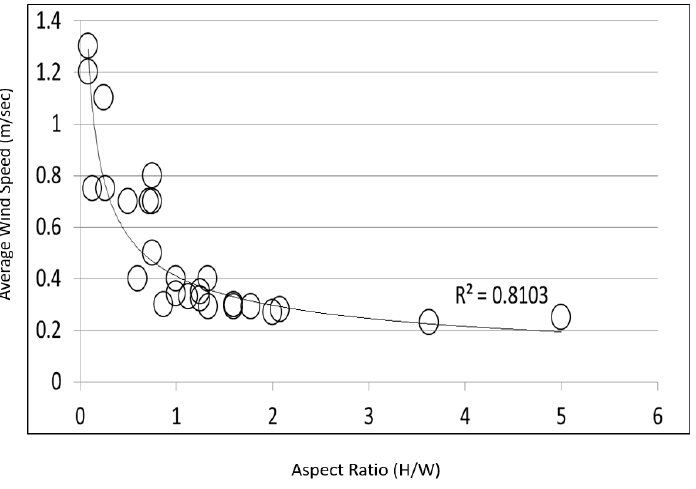
Figure 17. Entry and Exit Wind Speed in Canyons with Air Flow Parallel to their Axis. 7. Conclusions Urban overheating causes energy, environmental, and health problems while also impacting the overall economic and cultural life of cities. The implementation of a series of mitigation measures can compensate for the negative impact of the high urban temper- atures. The mitigation measures considered in this study include the increase of greenery in the various areas, the introduction of water sprays, and the change of urban materials’